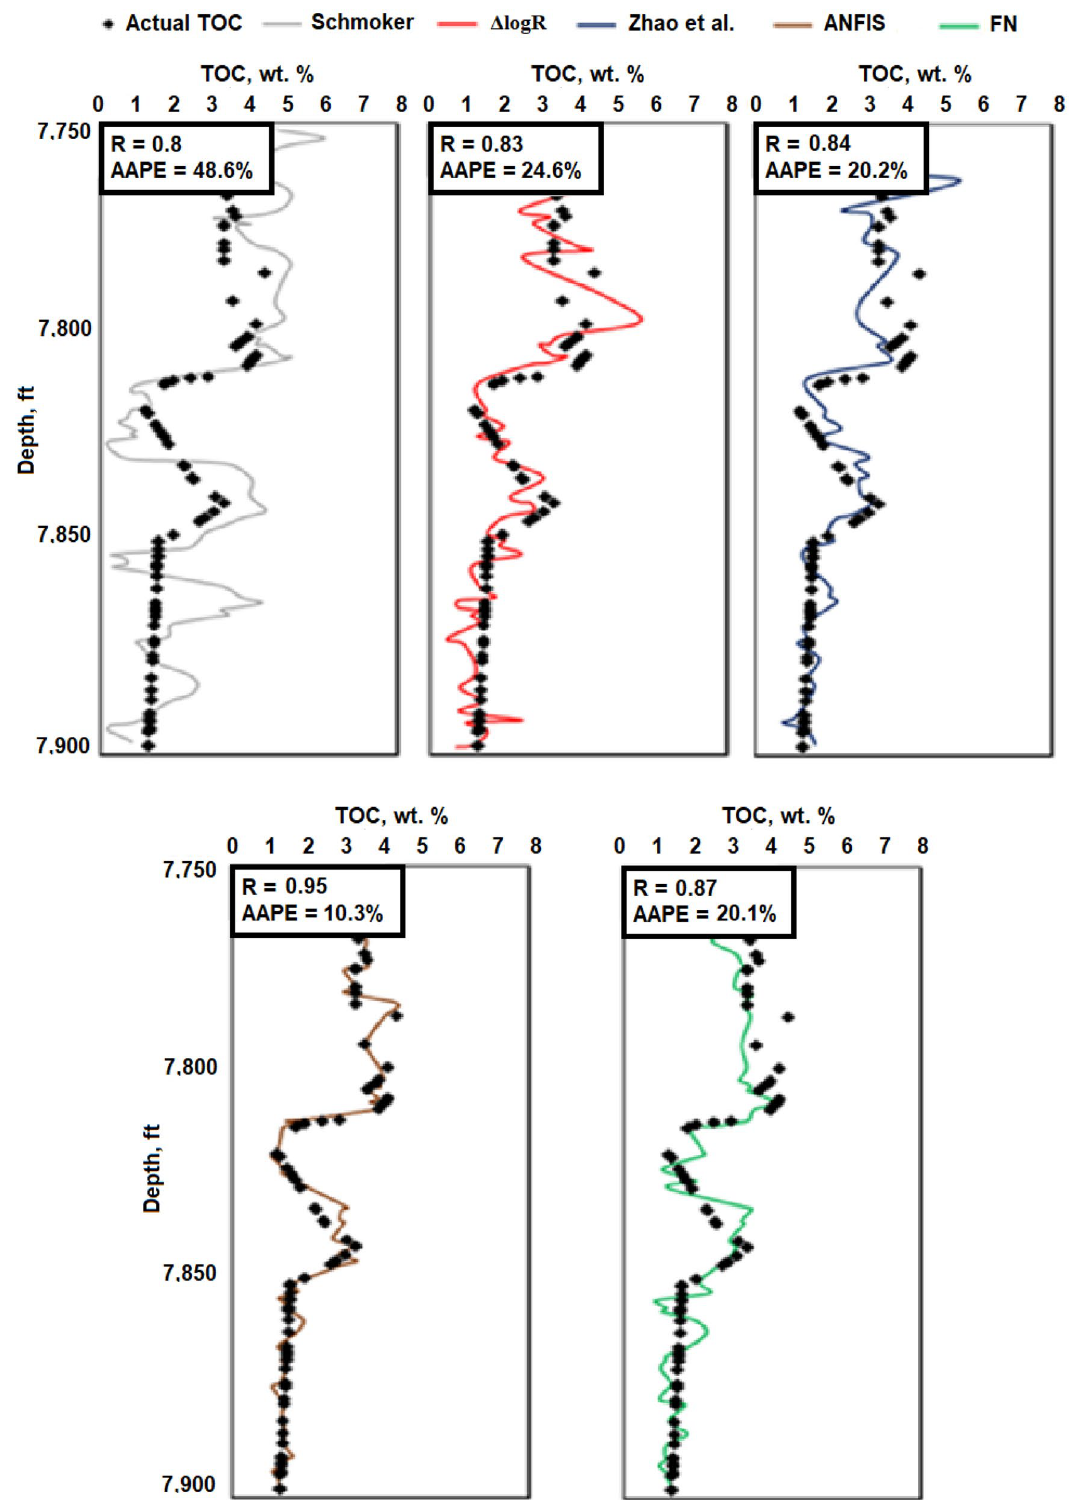
Fig. 11 AI-based against empirical correlations TOC prediction of